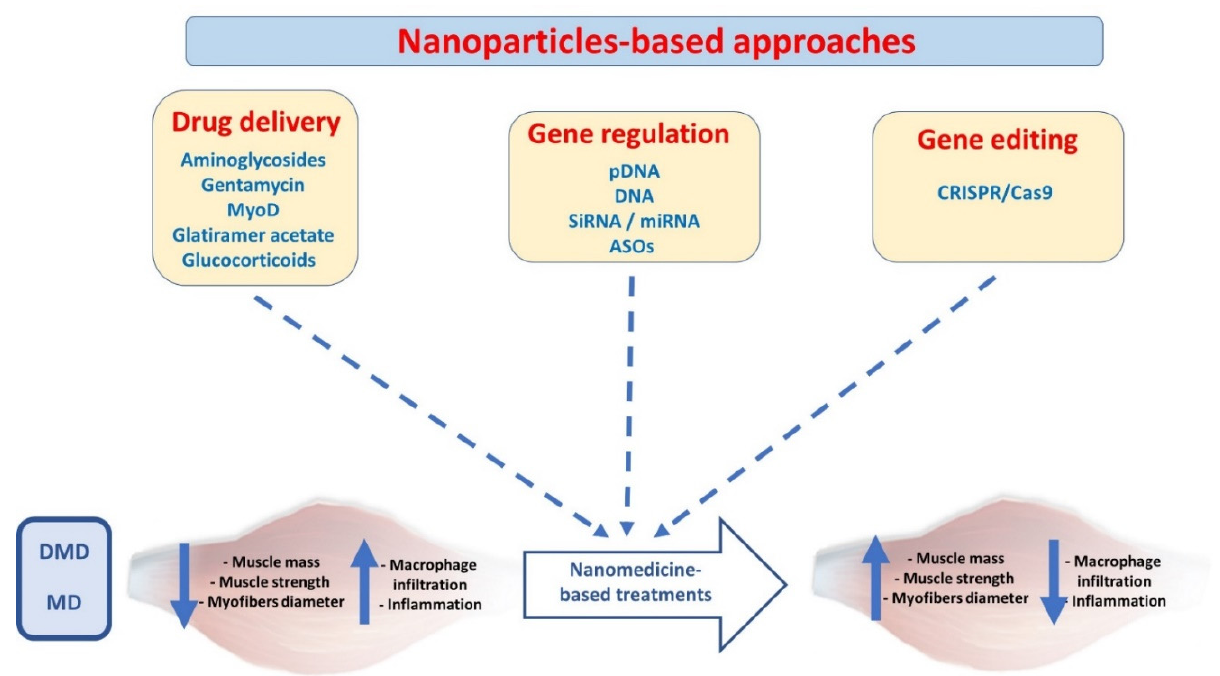
Figure 2. Nanoparticle-based approaches to treat skeletal muscle dystrophies. (MyoD; myoblast determination protein 1, pDNA; plasmid DNA, siRNA; small interference RNA, miRNA; micro-RNA, ASO; anti-sense oligonucleotides, DMD; Duchenne muscular dystrophy, MD; myotonic dystrophy).